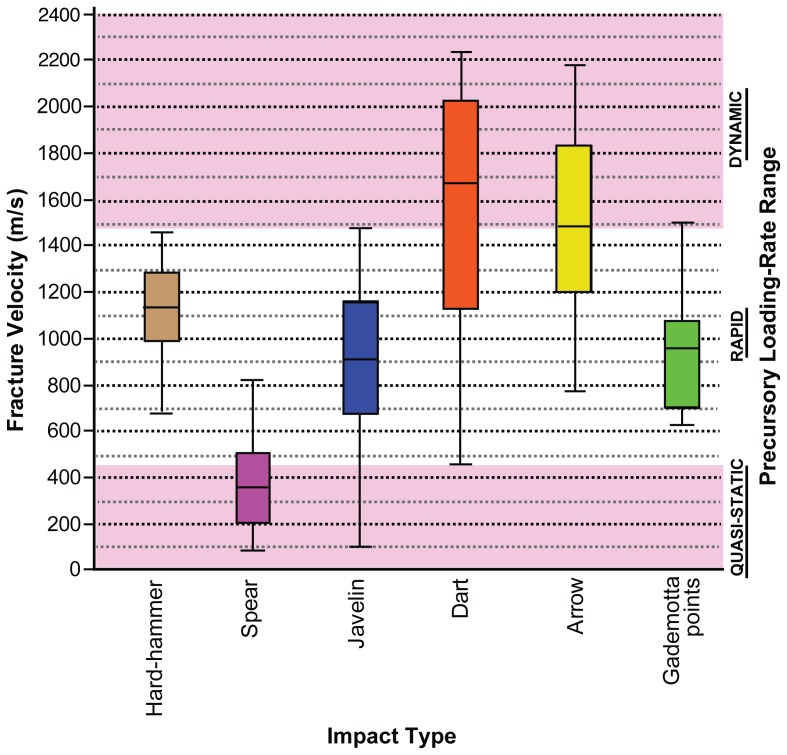
Box-and-Whisker plots of instantaneous fracture velocities for various impact types.Comparison established by experimental work using obsidian raw material with a distortional wave velocity (C
2) of 3865 m/s [11]. Boxes represent inter-quartile ranges; the horizontal lines inside the boxes represent the median values; the tails represent the non-outlier range.